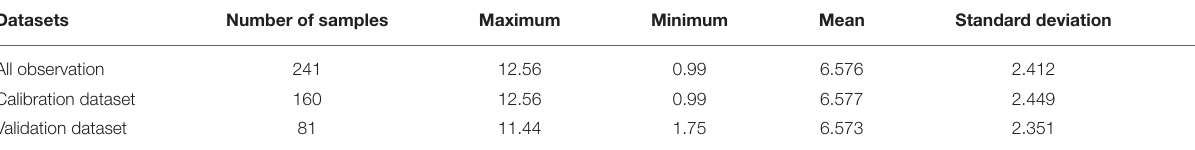
TABLE 3 | Statistics analysis of the leaf nitrogen accumulation (LNA) (g/m 2 ) of winter wheat. Datasets Number of samples Maximum Minimum Mean Standard deviation p (K-S)